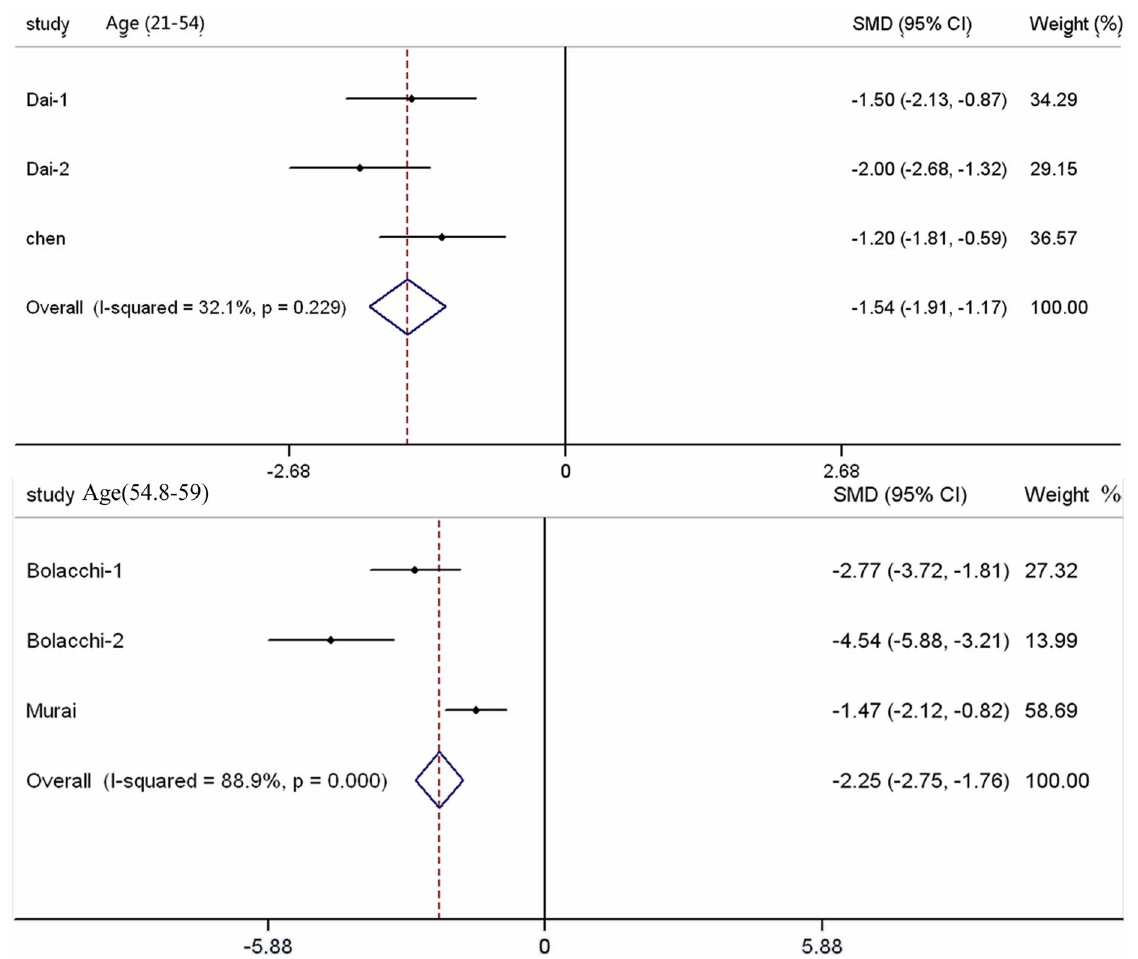
Figure 6. Results of an FA analysis with respect to age in optic radiation of patients with glaucoma compared with controls. There is an apparent difference between two age groups (a: age 21–54 years, b: age 54.8–59 years). We can conclude that there was decreasing FA of the optic radiation with increasing age in patients with glaucoma (P , 0.05, and the diamond shape appears on the left side). FA: fractional anisotropy; SMD: standardized mean difference; CI: confidence